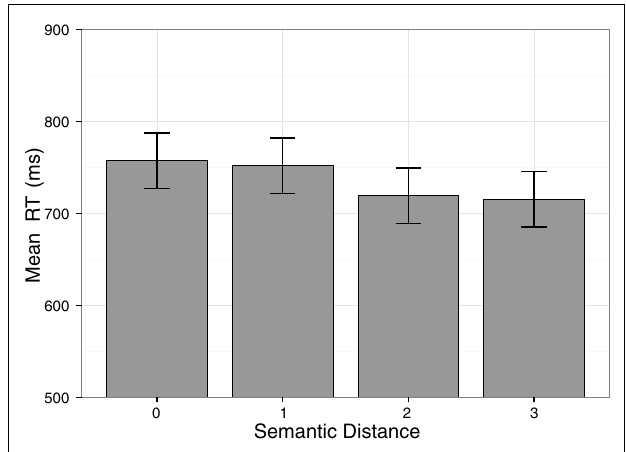
FIGURE 2 |The cross-modal semantic distance effect between tactile and symbolic numerosities for sequential tactile stimulation. Mean response times are significantly shorter for a large semantic distance of 2 and 3 than for a small semantic distance of 1. Error bars represent 95% within-subject confidence intervals (cf. Loftus and Masson,